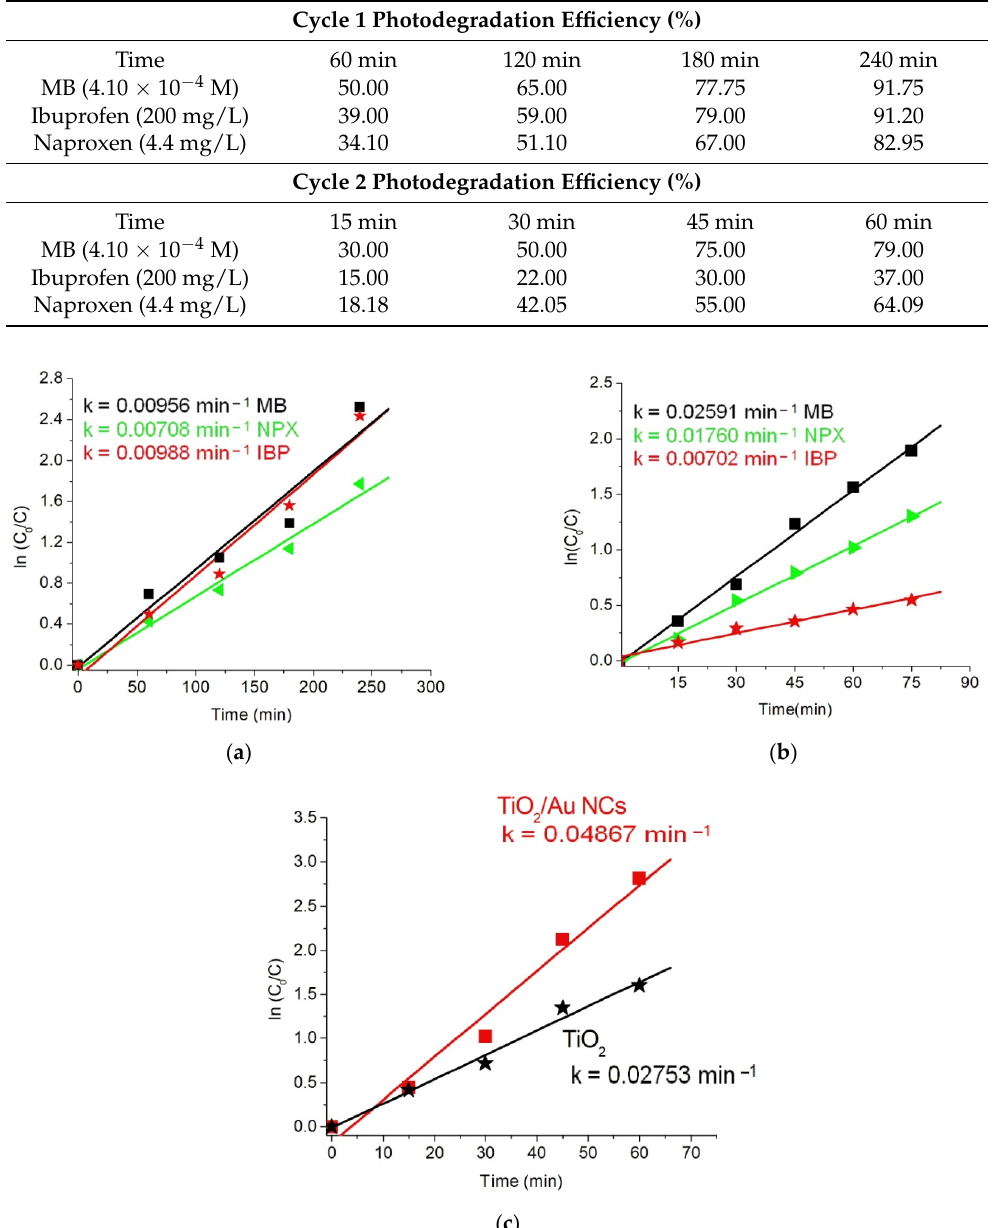
Table 1. Solar-assisted photodegradation efficiencies of {001}-TiO 2 /Au NCs for cycles 1 and 2. Cycle 1 Photodegradation Efficiency (%)